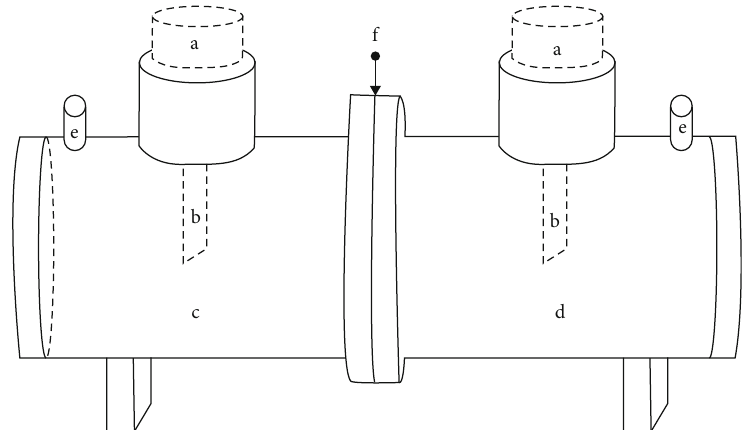
Figure 1: Lab scale permeation cell: (a) stirring motors; (b) stirrers; (c) feed compartment; (d) strip compartment; (e) sample collection port; and (f) supported membrane.